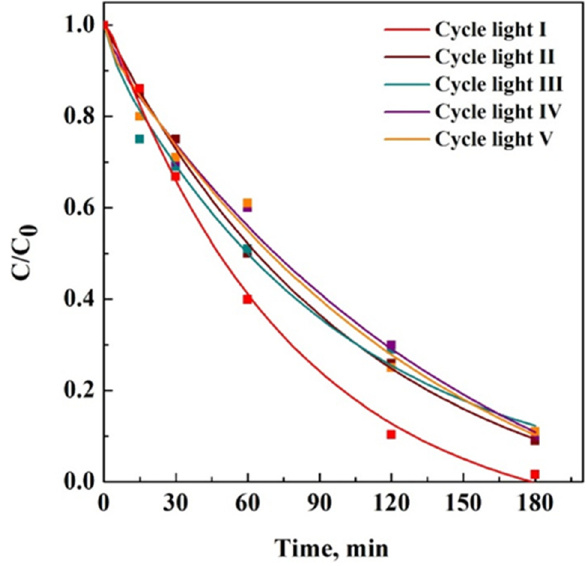
Figure 10. Adsorption cycles of 15VPDF-coHFP_20TiO 2 membrane under exposure to UV light. This result was confirmed by FT-IR spectra reported in Figure 11.